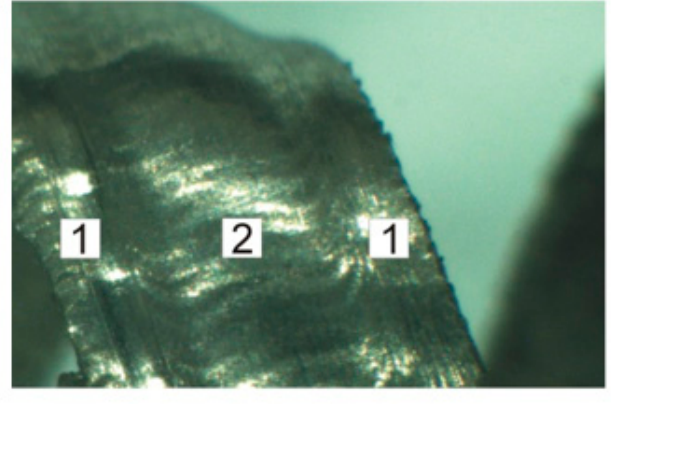
Figure 4. ( a ) Characteristic areas 1 and 2 on the chip surface and ( b ) corresponding areas on the rake face of the insert [36].